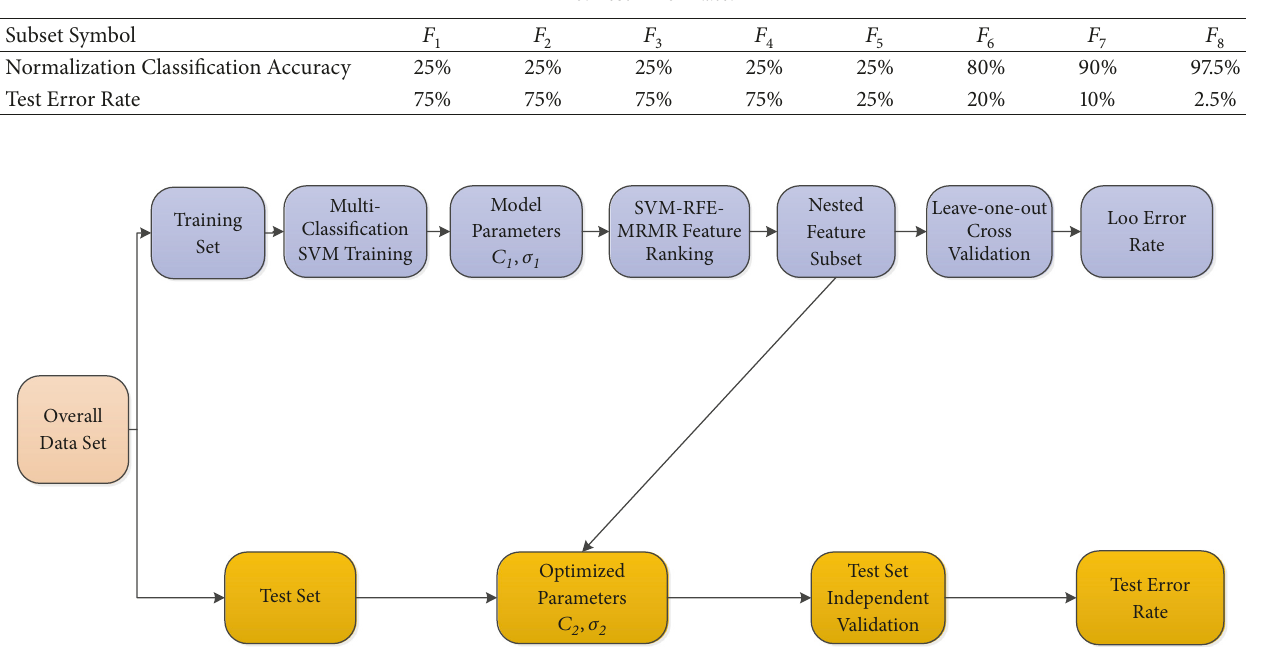
Table 6: Test Error Rate.